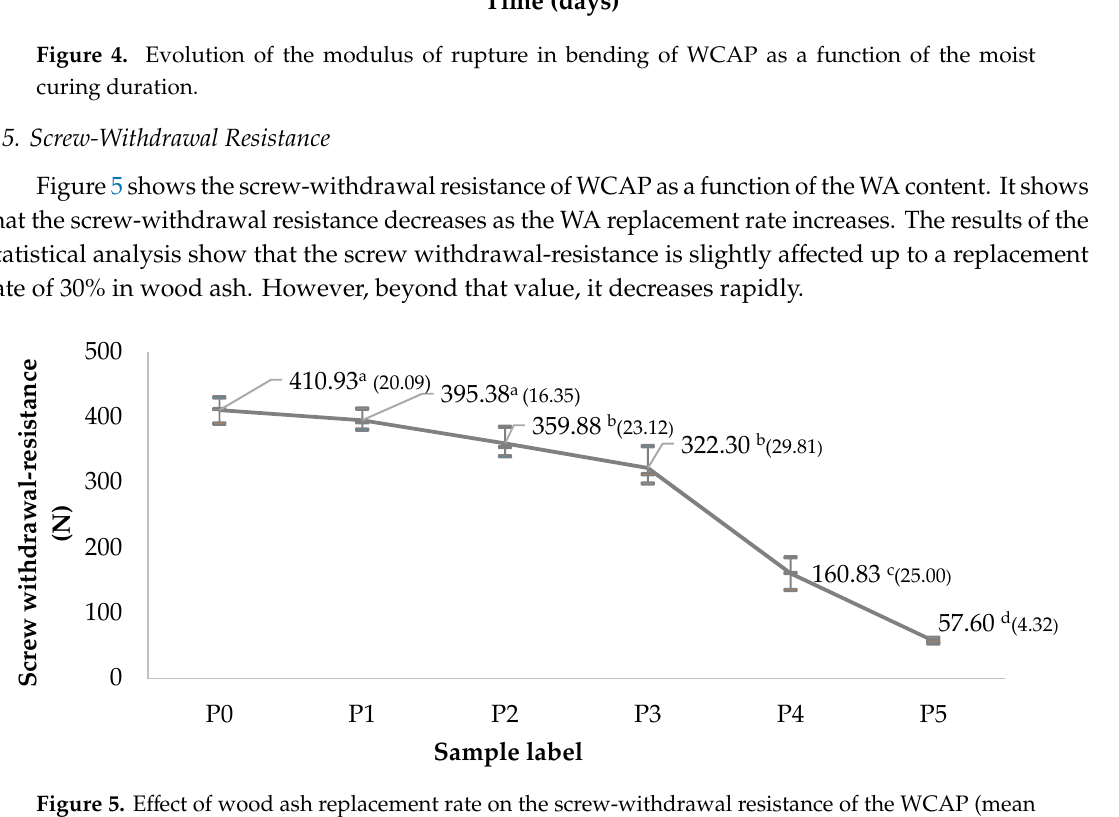
values with the same superscript are not significantly different for p = 0.05; standard deviation is given